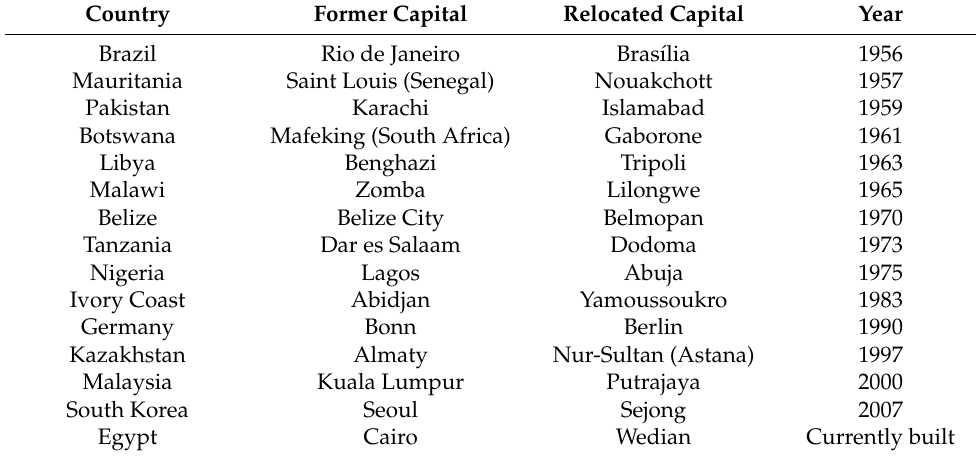
Table 1. Examined capital